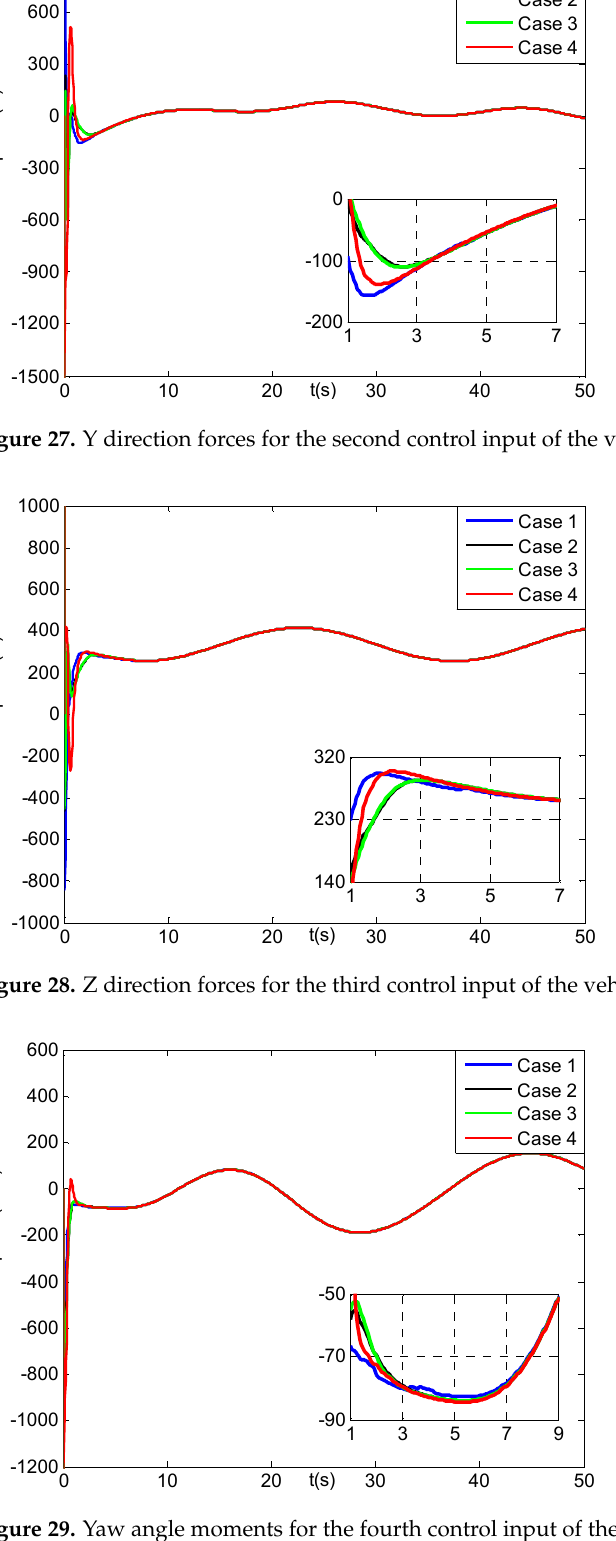
Figure 26. X direction forces for the first control input of the vehicle (four cases).